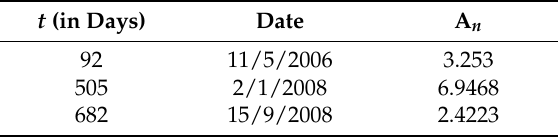
Table 10. Change points in the estimated bivariate jump time series for Google with the corresponding test statistic value.